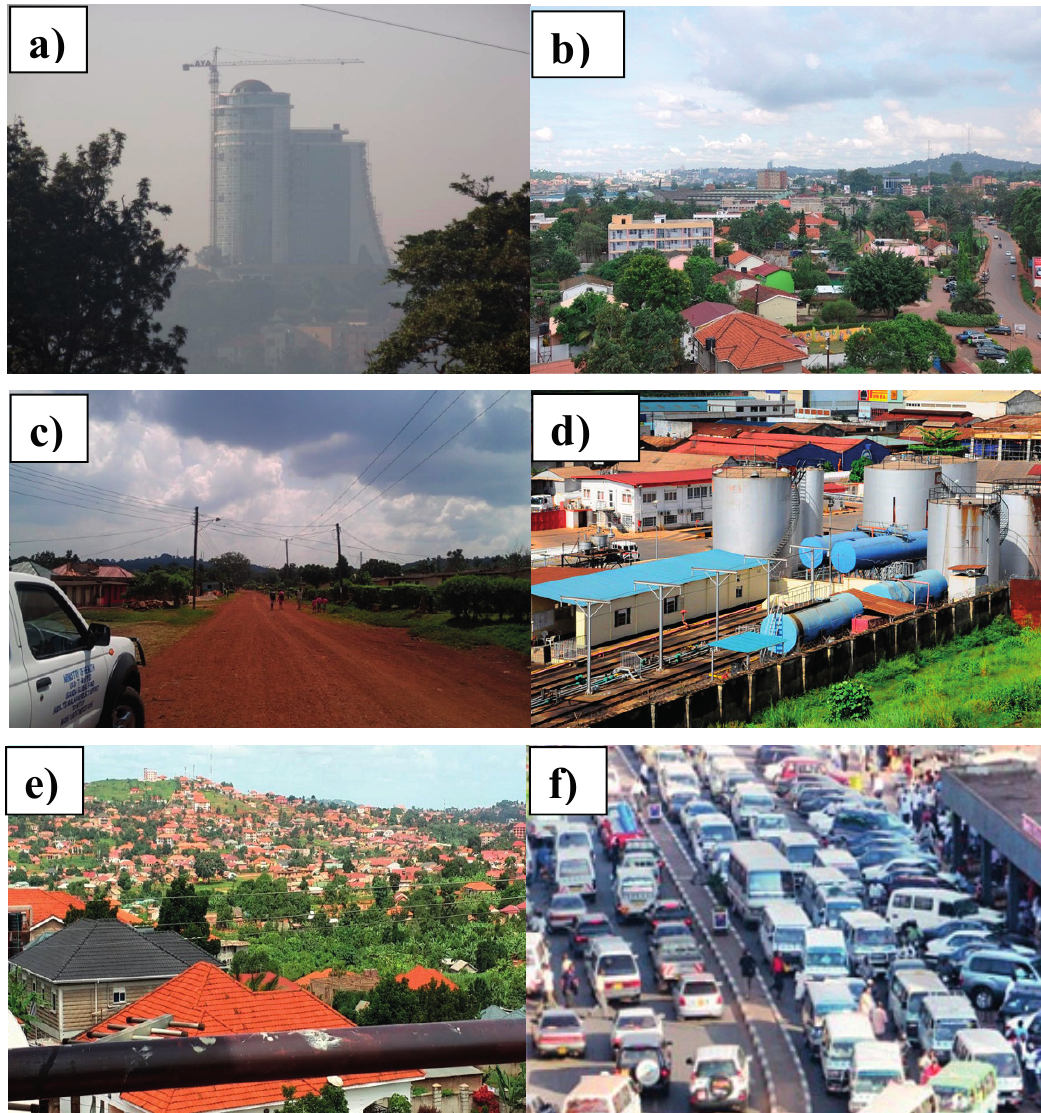
Figure 1. Representative images of sampling sites. Sampling site: a ) central monitoring site; b ) paved residential; c ) unpaved residential, low income; d ) industrial area; e ) unpaved residential high income; and f ) commercial